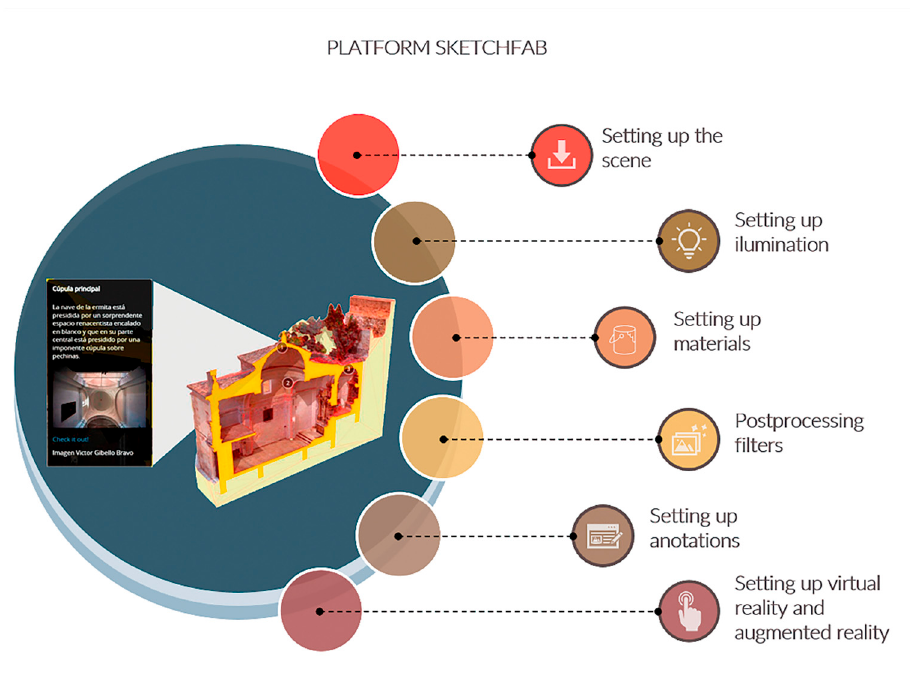
Figure 25. Development of the functionalities of Sketchfab.